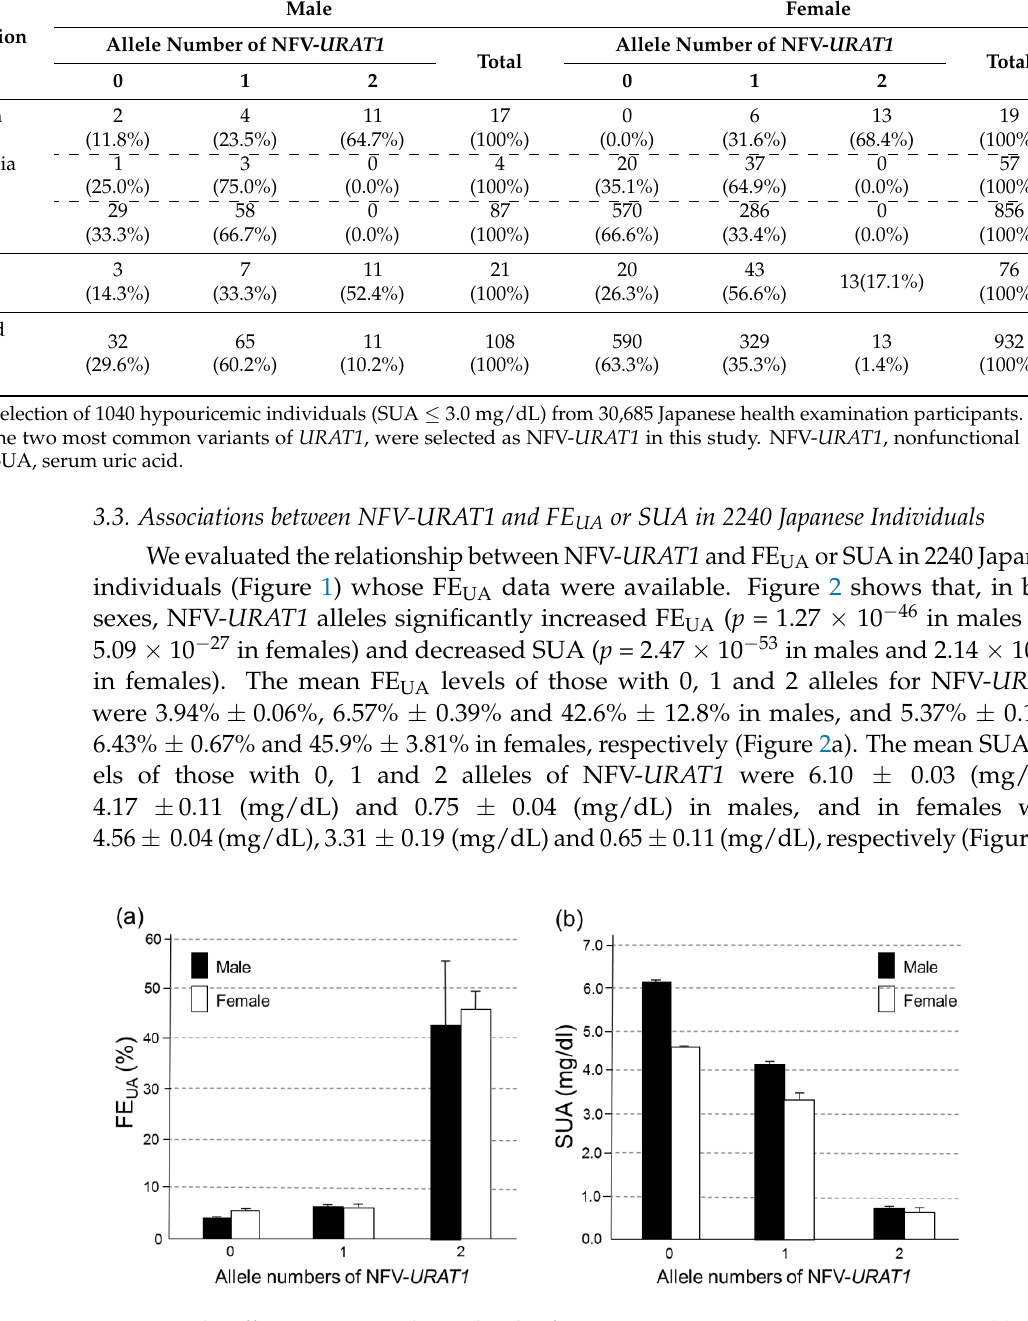
Figure 2. The effect on FE UA and SUA levels of NFV- URAT1 in 2240 Japanese participants: ( a ) FE UA and ( b ) SUA levels of participants with 0, 1 and 2 alleles of NFV- URAT1 are shown for each sex. Among the 1542 male participants (black bars), 1472, 68 and 2 participants had 0, 1 and 2 alleles of NFV- URAT1 , respectively. Among the 698 female participants (white bars), 678, 18 and 2 participants had 0, 1 and 2 alleles of NFV- URAT1 , respectively. The presence of NFV- URAT1 alleles significantly increased FE UA ( p = 1.27 × 10 − 46 in males and p = 5.09 × 10 − 27 in females), and significantly decreased SUA ( p = 2.47 × 10 − 53 in males and p = 2.14 × 10 − 13 in females). W258X and R90H, the two most common variants of URAT1 , were selected as NFV- URAT1 in this study. All bars are expressed as means ± SE. FE UA , fractional excretion of uric acid; SUA, serum uric acid; NFV- URAT1 , nonfunctional variants of